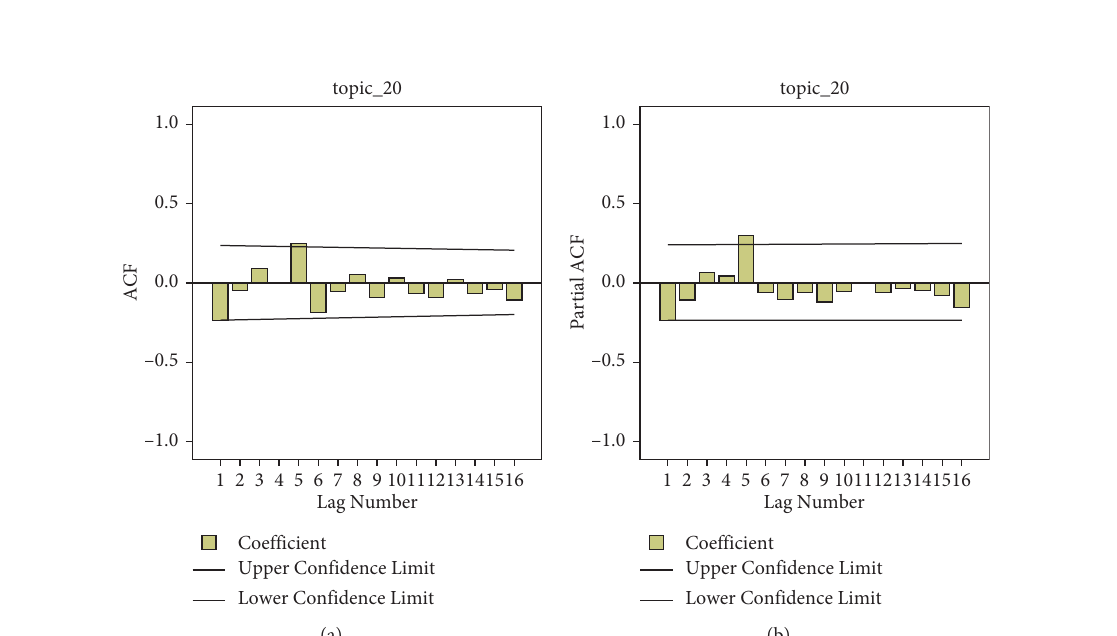
Figure 12: Autocorrelation and partial autocorrelation plots of subject 20 heat after 1st-order differencing. (a) Autocorrelation. (b) Partial